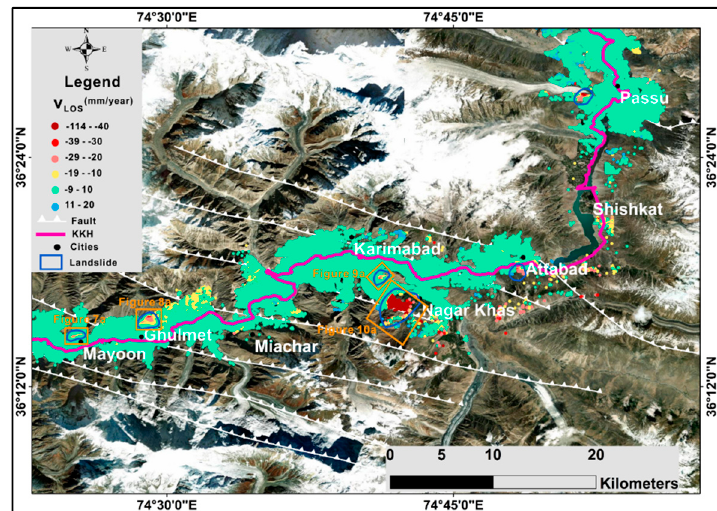
Figure 5. The average velocity in line of sight (LOS) from February 2017 to August 2019 plotted in Google Earth over a part of Hunza-Nagar region. The blue polygons represent the high deformation zone detected using SBAS-InSAR technique.